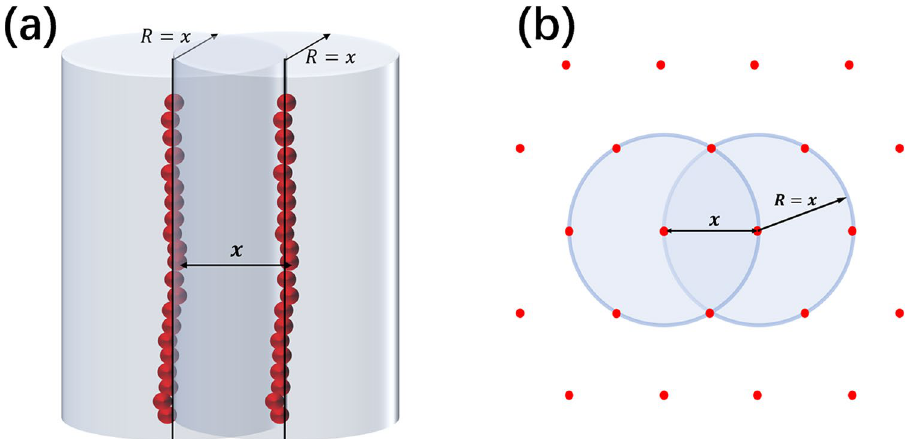
Figure 1. ( a ) Schematic representation of the model system with two like-charged polyelectrolytes (PEs) each of which is confined in a cylindrical boundary with radius R = x . x is the separation between the centers of the central monomers of the two PEs. The PEs are represented by worm-like bead chains with intrinsic bending persistence length P . ( b ) Top view of a hexagonal array of PEs. The condensed PEs such as DNAs are generally